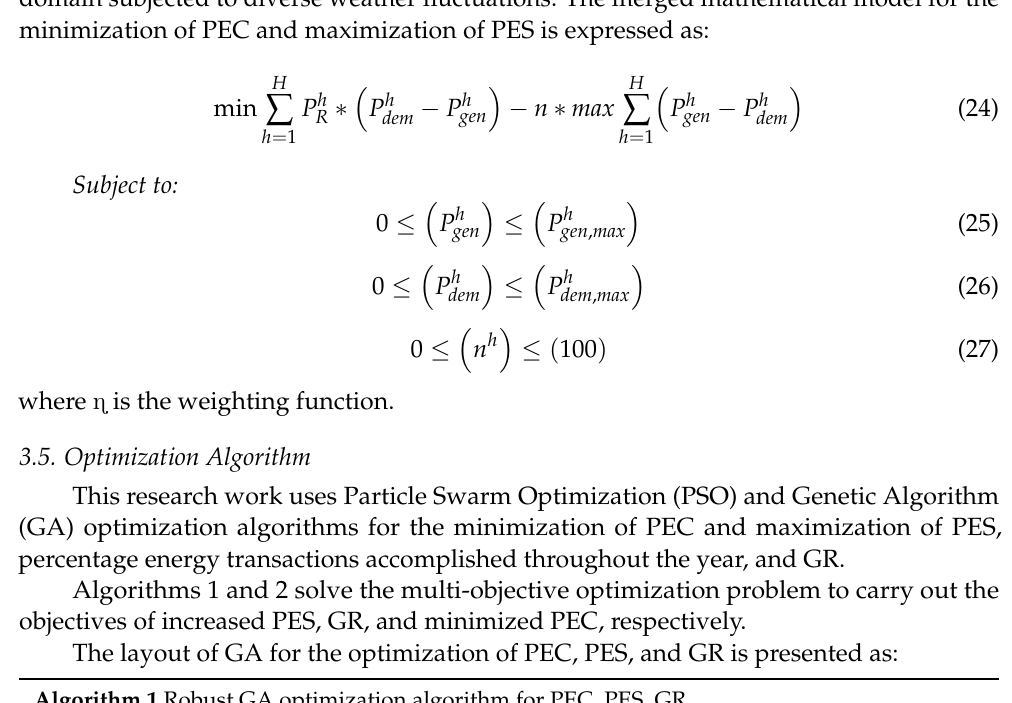
Algorithm 1 Robust GA optimization algorithm for PEC, PES, GR